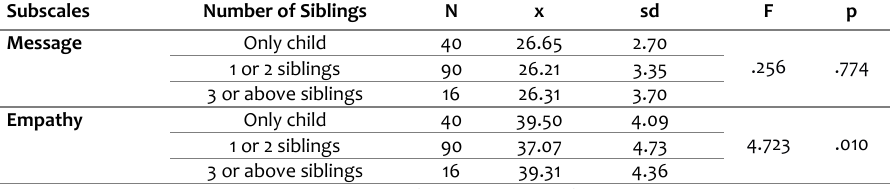
Table 2. The Parent-Child Communication Assessment Tool (PCCAT) ANOVA Results regarding the Subscale Scores for the Number of Children’s Siblings